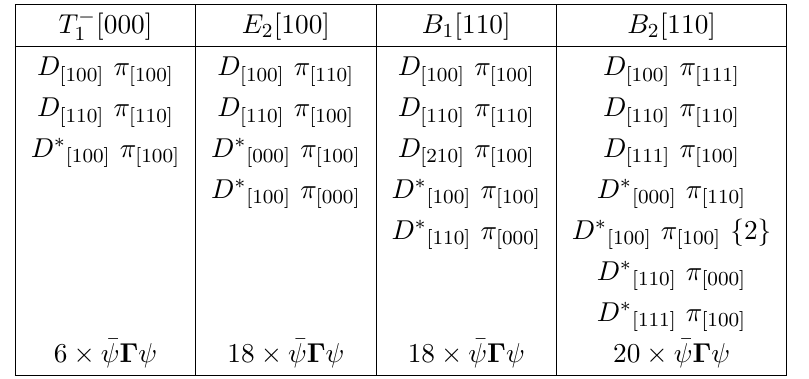
Table 7. As table 6, but for operators used in irreps without an S -wave Dπ subduction. The number in curly parentheses indicates the number of operators of this momentum